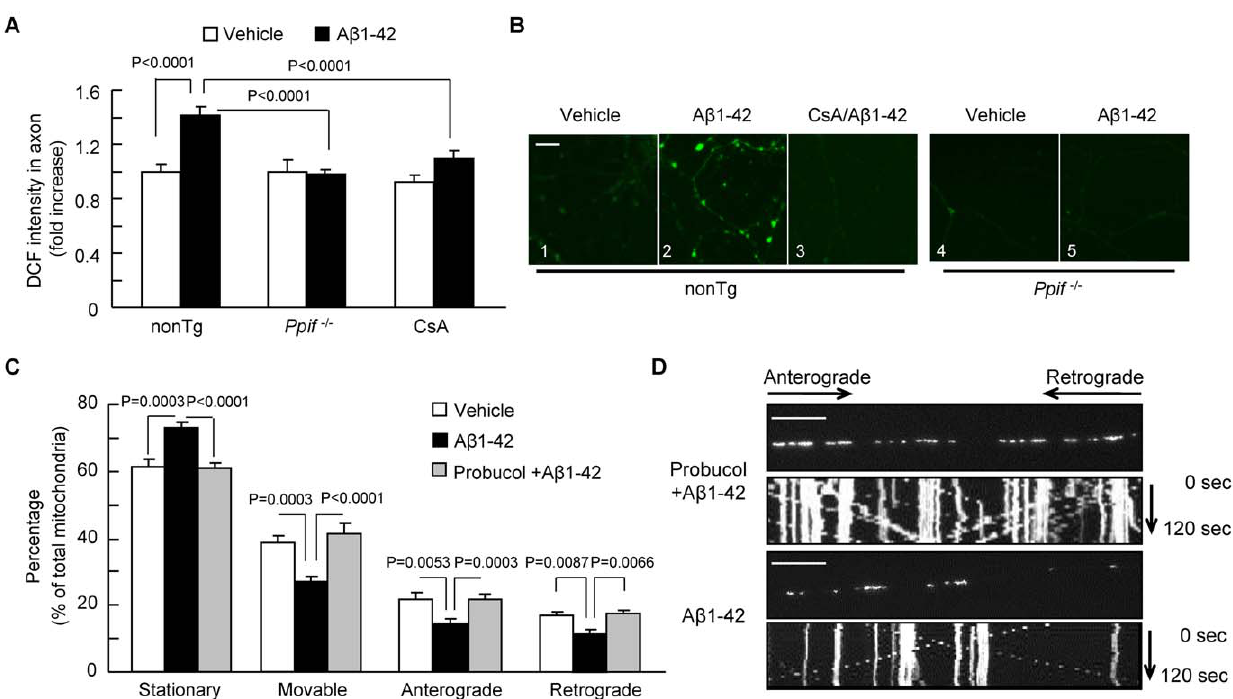
Figure 4. CypD depletion attenuates A b -induced intra-axonal ROS elevation. ( A ) Quantification of DCF intensity in nonTg- or Ppif 2 / 2 hippocampal neurons treated with vehicle or A b . Addition of CsA (500 nM) to cells for 24 hours reduced the DCF intensity. Data were derived from 3 independent experiments. ( B ) Representative images of axonal DCF staining in nonTg and Ppif 2 / 2 hippocampal neurons for the indicated treatment. Scale bar is 10 m m. ( C–D ) Effect of antioxidant (Probucol) on A b -induced axonal mitochondrial motility. ( C ) Administration of Probucol (5 m M, 24 hours) ameliorated changes in A b -induced axonal mitochondrial motility. ( D ) Kymograph images show the protected effects of axonal mitochondrial moving traces following Probucol treatment. Scale bar is 10 m